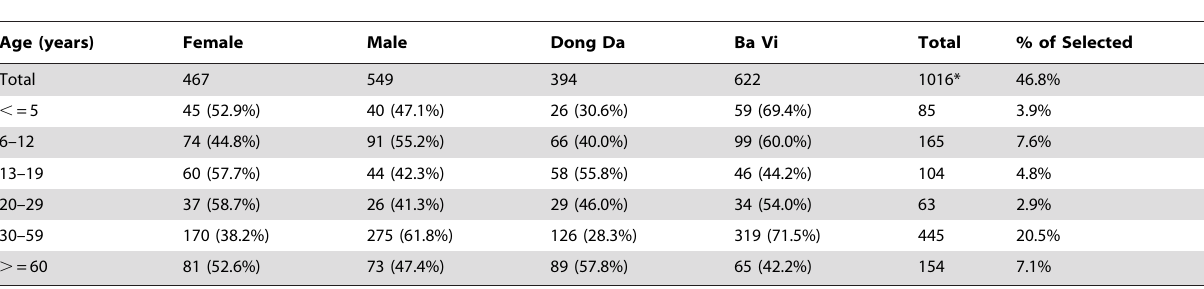
Table 1. Distribution of study subjects, stratified by age, sex, and living location.